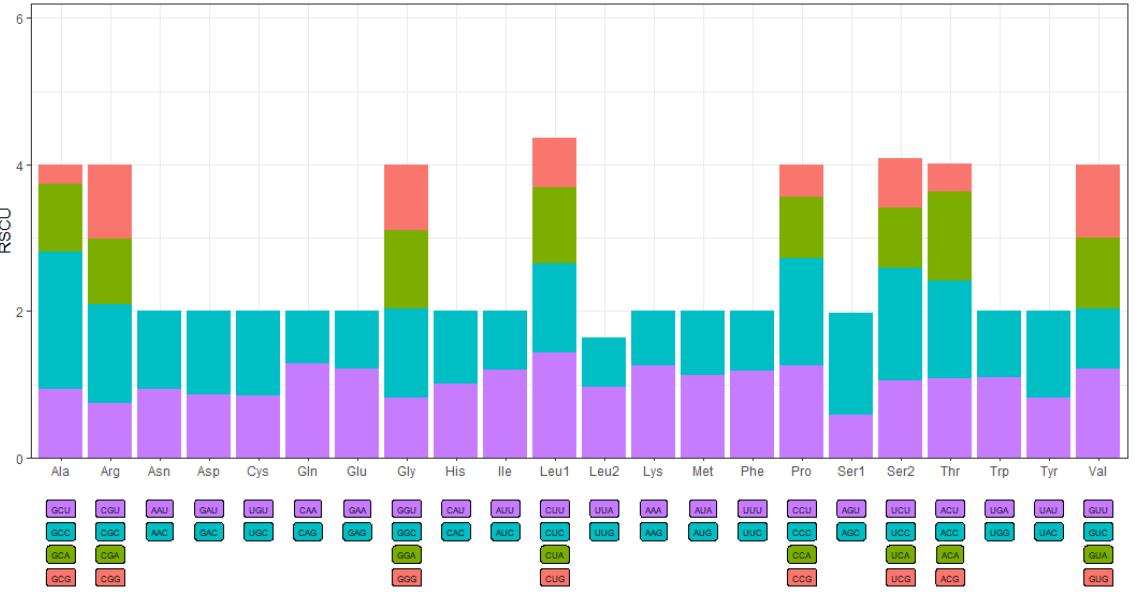
Figure 2. Relative synonymous codon usage (RSCU) of Chaenogobius annularis . Codon families are plotted on the x-axis. Codon type is presented beneath each codon family. On the histogram, the proportion of each codon type (retaining same color code) as a proportion of the respective codon family.